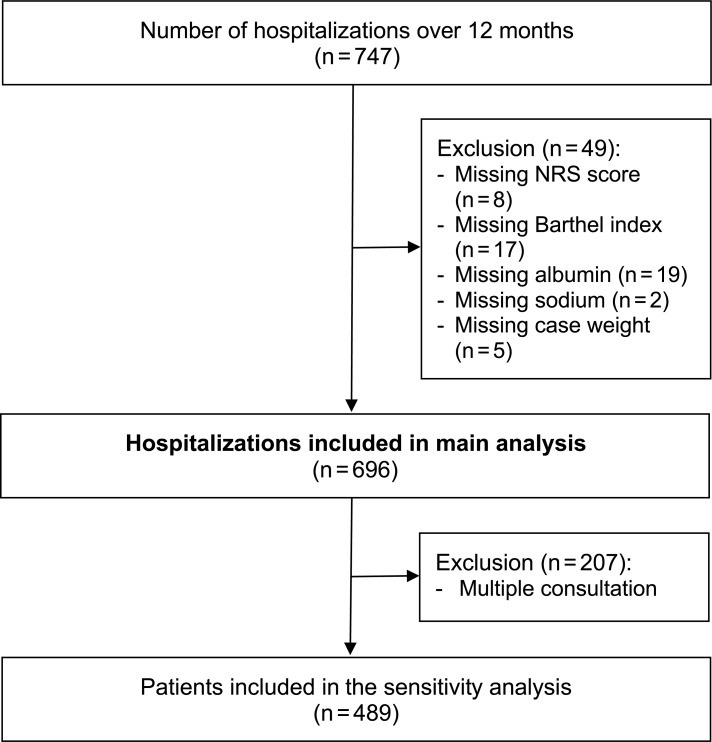
Flowchart.Abbreviations: NRS, Nutrition Risk Screening.